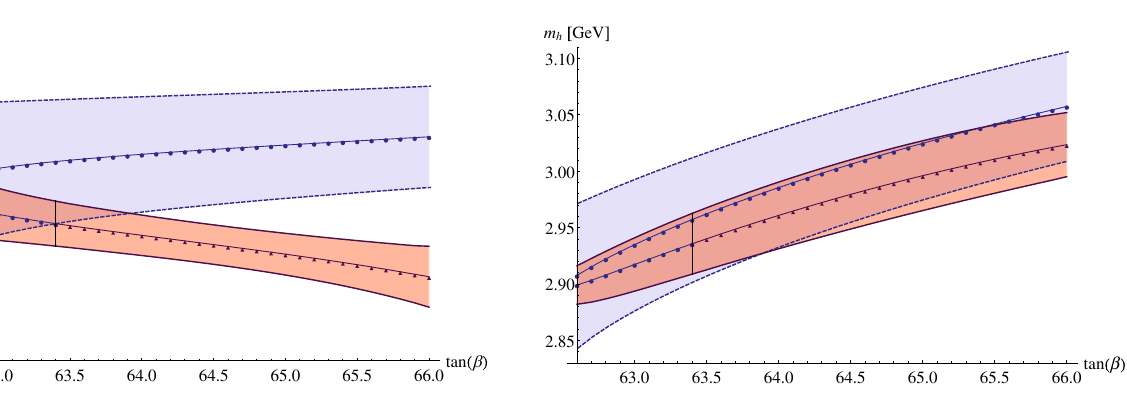
Fig. 2 Mass eigenstates of the light CP-even neutral scalar Higgs boson h in the type II Z 2 -symmetric model, as labelled in Fig. 1